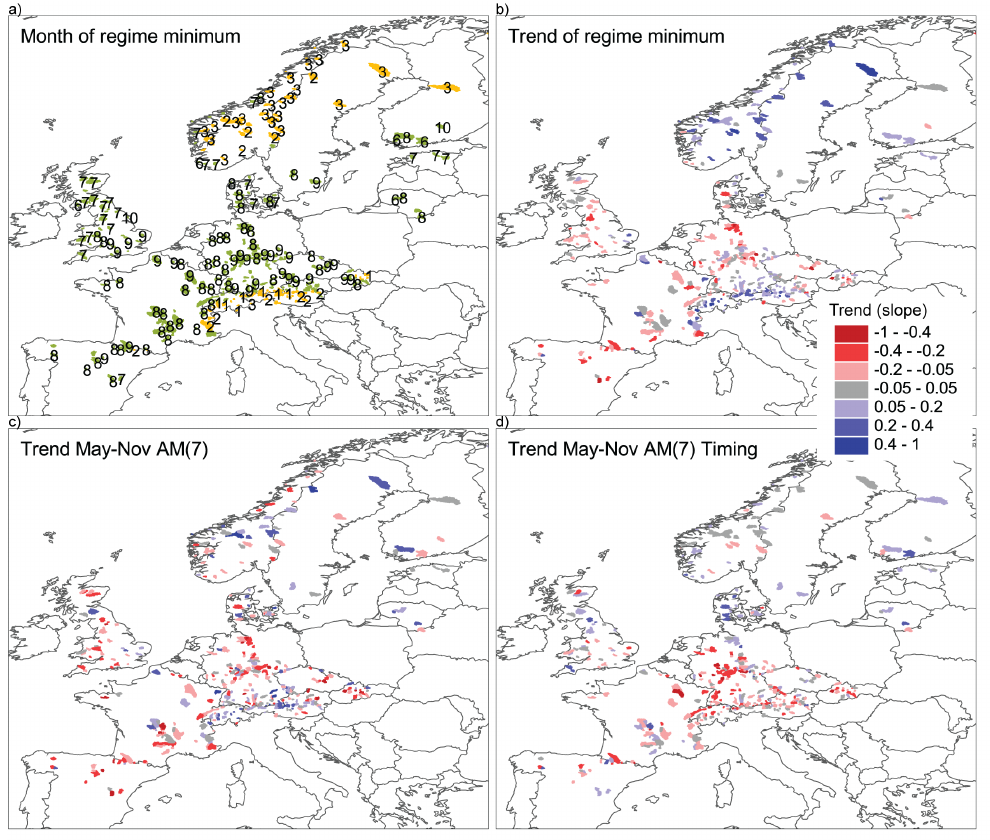
Fig. 3. (a) The month of the regime minimum, (b) trend for mean monthly streamflow for the month of the regime minimum, (c) trend for AM(7) during May–November, (d) trend for the timing of AM(7) during May–November. All trends are for the period 1962–2004 and given in standard deviations per